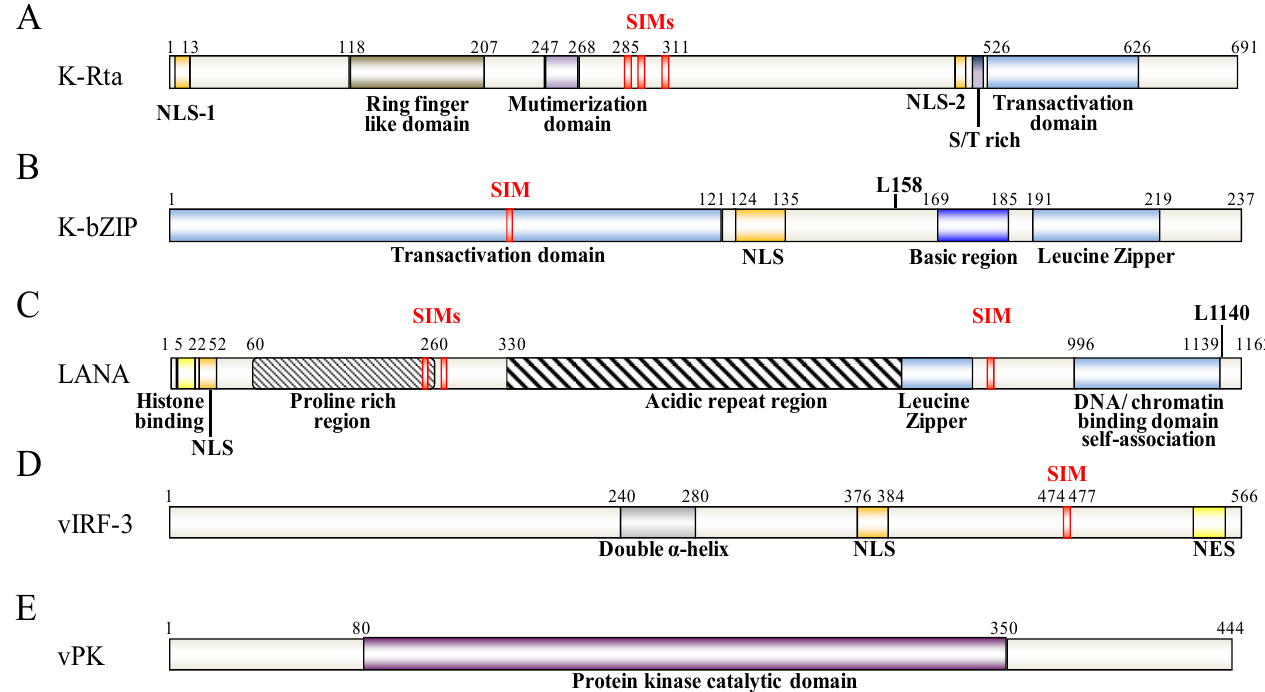
Figure 2. Schematic representation of KSHV K-Rta ( A ), K-bZIP ( B ), LANA ( C ), vIRF-3 ( D ) and vPK ( E ). The functional domains of these proteins are indicated below the